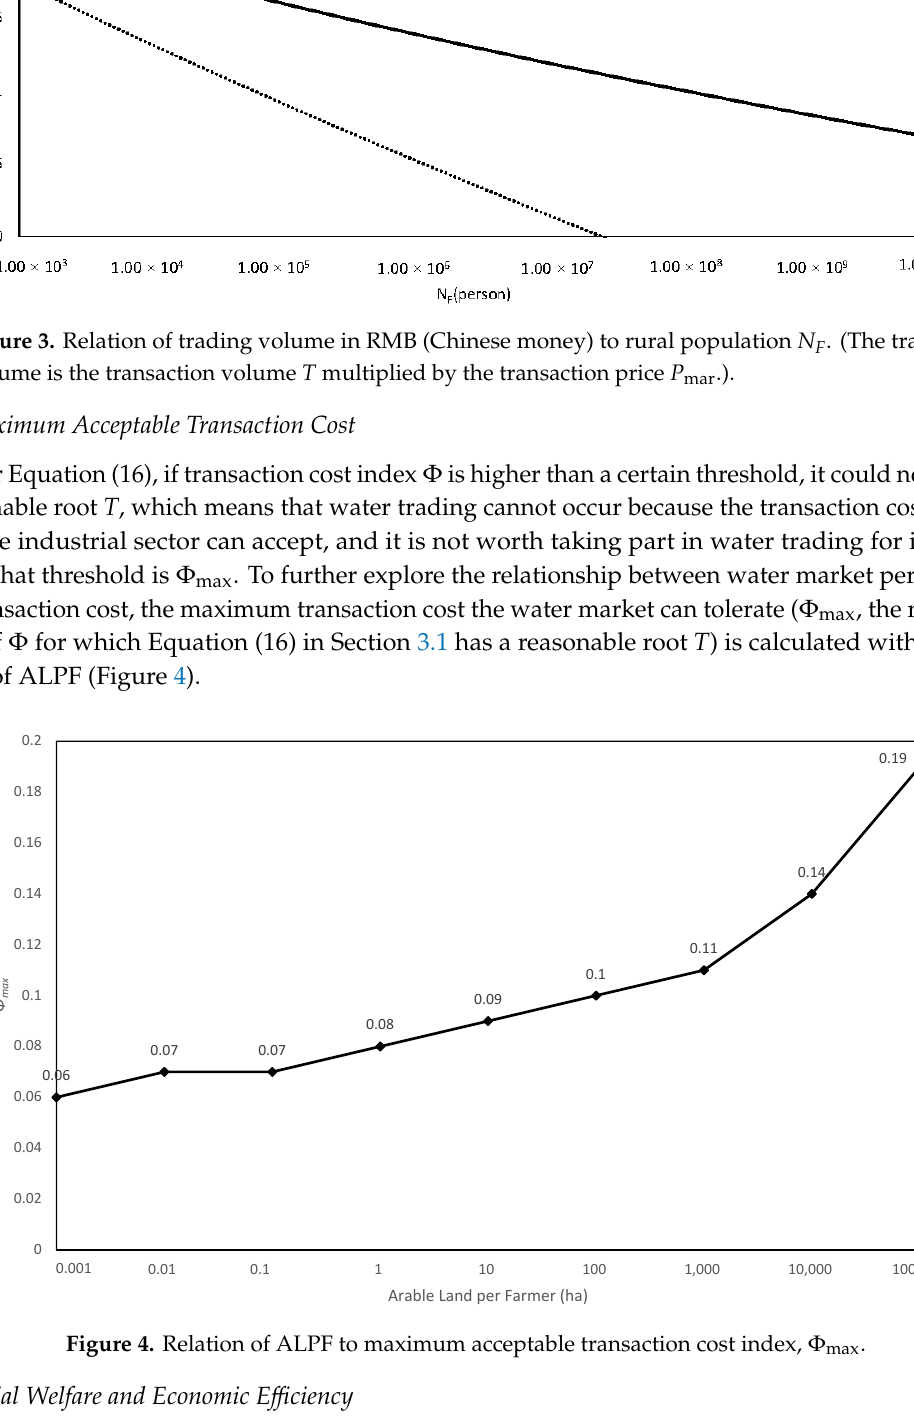
Figure 2. Relation of transaction volume T to rural population N F .